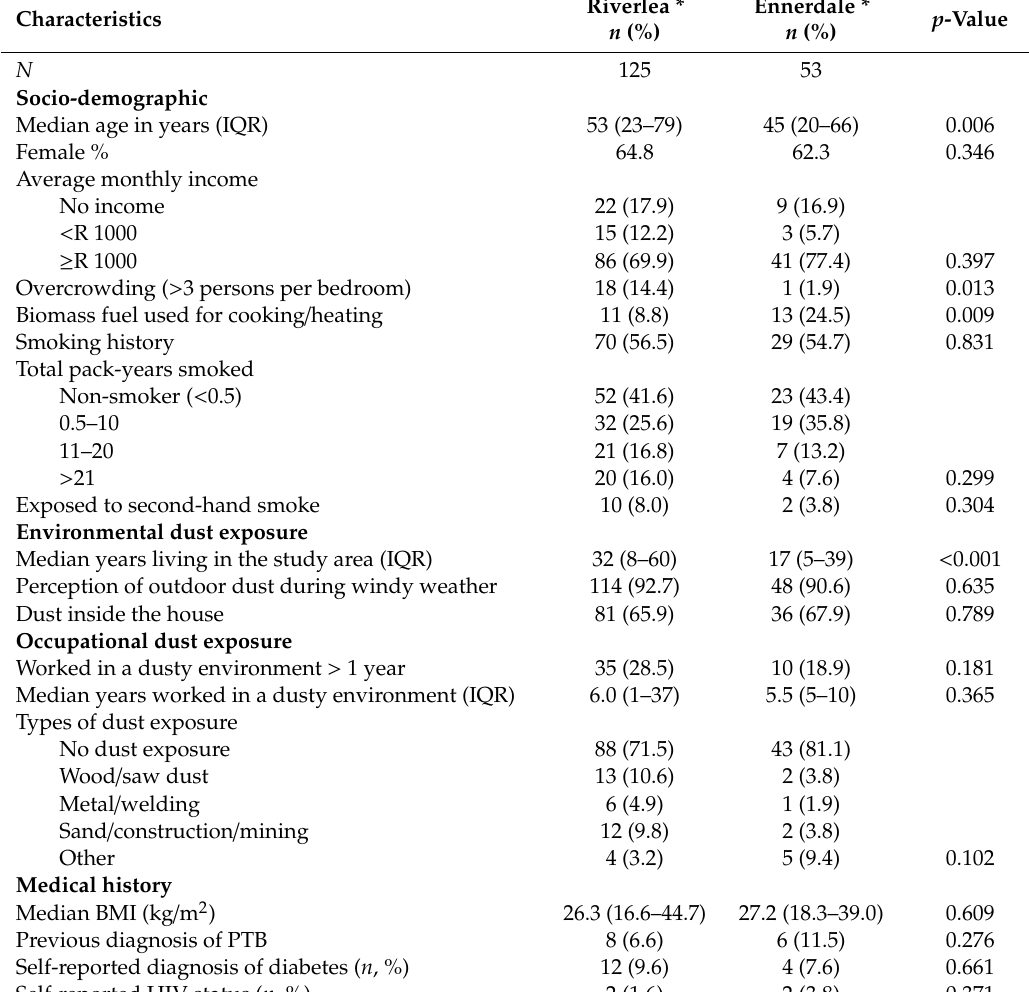
Table 1. Description of the study population ( n =